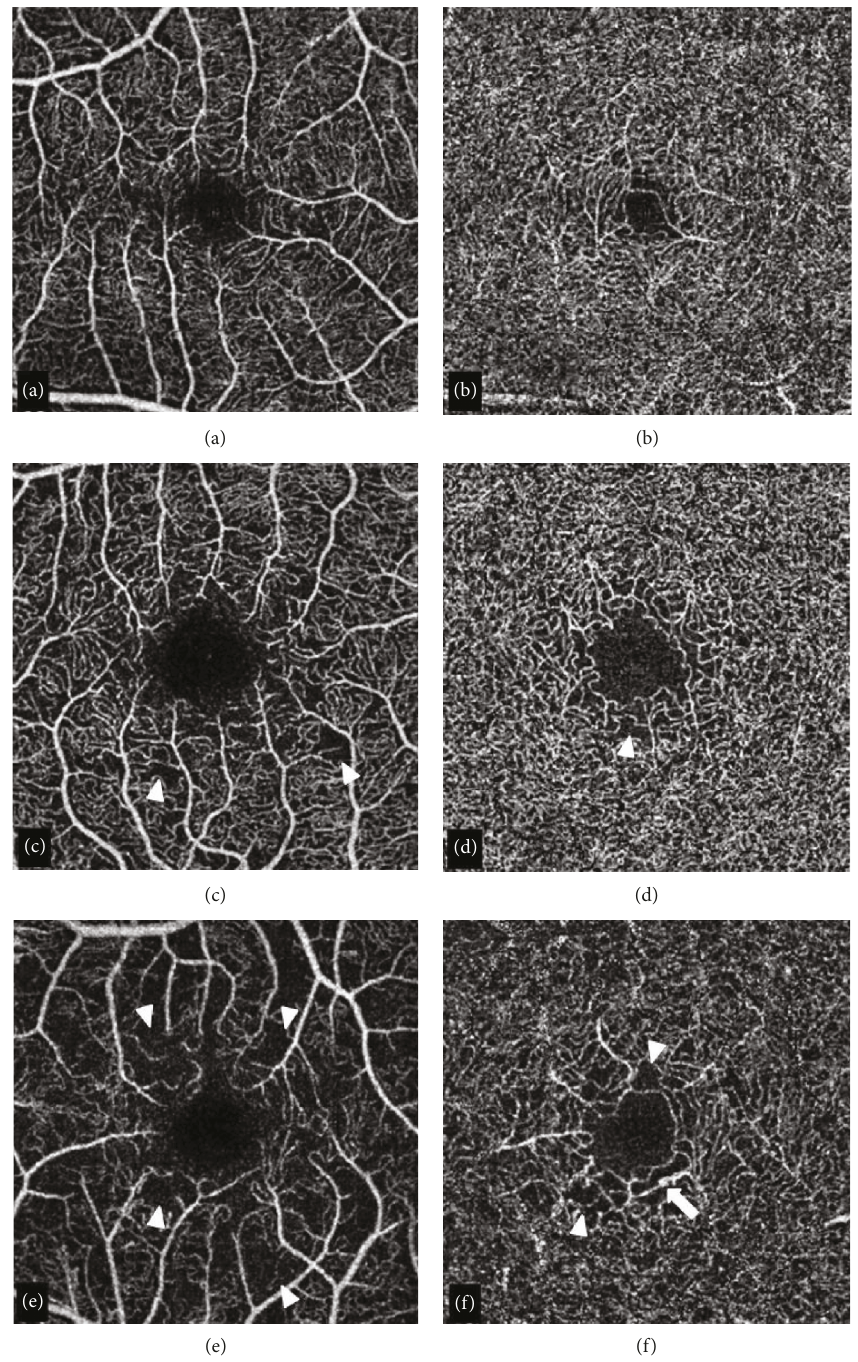
Figure 1: Optical coherence tomography angiography images. (a, b) Optical coherence tomography angiography (OCTA) in a healthy control showing the typical spider web appearance of the super fi cial capillary plexus (SCP) (a) and the sea fan pattern of the deep capillary plexus (DCP) (b). (c – f) SCP (c and e) and DCP (d and f) in two patients (c and d) patient #40; (e and f) patient #28) showing early vascular changes at the level of both retinal plexus. In these cases, indeed mild capillary loss with reduced vascular density was better visible at the level of the SCP whereas microaneurysms could be recognized at the level of the deep vascular structures. Arrow: microaneurysm; arrowhead: areas of capillary